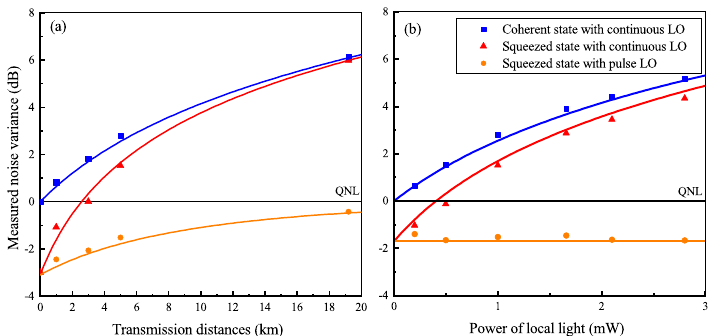
Figure 4. The dependence of measured noise variances of the signal beam on the transmission distance ( a ) and the power of the LO beam in BHD2 ( b ) in the fiber. The square is the result when LO beam was continuous and the signal beam was a coherence state. The triangle is the result when LO beam was continuous and the signal beam is a quadrature amplitude squeezed state. The dot is the result when the LO beam was pulsed and the signal beam is squeezed state. The solid traces are the corresponding calculation results, which was in good agreement with the experimental